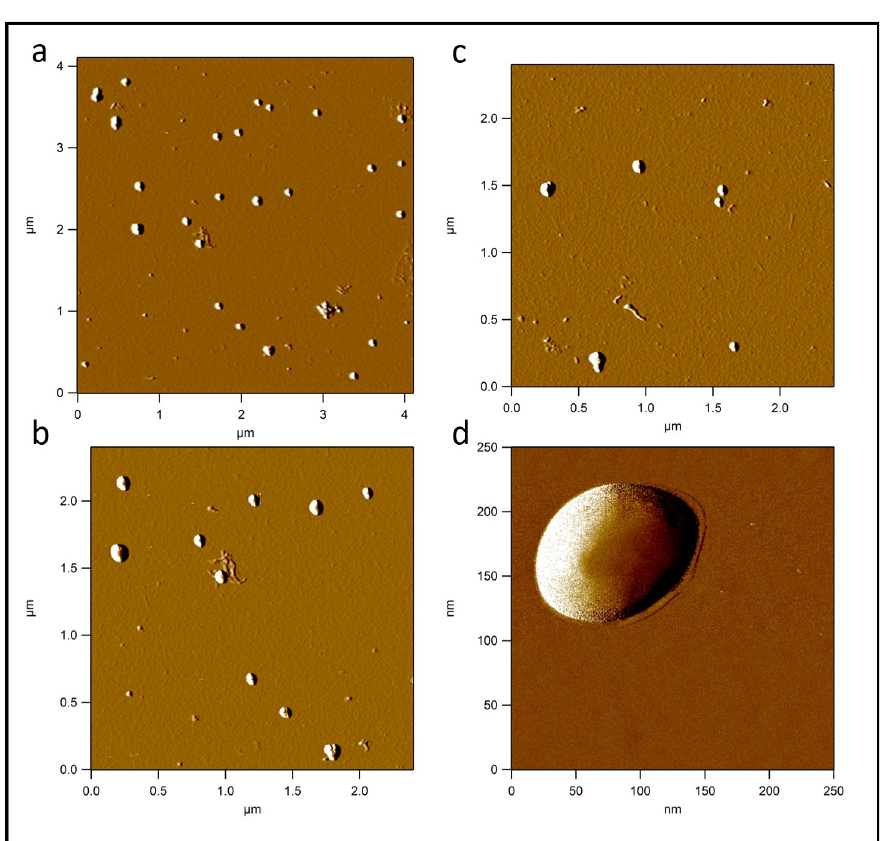
Fig 2. Atomic force microscopy (AFM) amplitude-contrast images with different magnification of PBNPs on mica surface. PBNPs on AFM images as objects with a flat rectangular surface protruding from a rounded halo. The rectangular surface represents the real geometry of the particles while their halo is the consequence of tip convolution. Rectangularity of the particles (together with their halo) was found to be 0.774 ± 0.111 (mean ± SD), indicating that PBNPs indeed represent rectangular topography. The height of the particles was 36.457 ± 9.496 nm (mean ± SD). The size of the images are 4.125 μ m x 4.125 μ m (Fig 2A), 2.5 μ m x 2.5 μ m (Fig 2B and 2C) and 250 nm x 250 nm (Fig 2D)